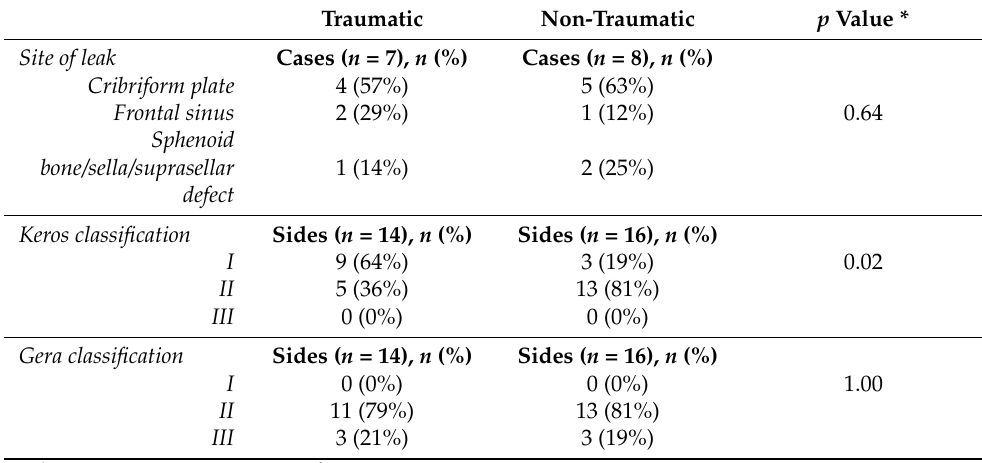
Table 4. Comparison of the site of leak and the Keros and Gera classifications in traumatic and non-traumatic CSF rhinorrhea.